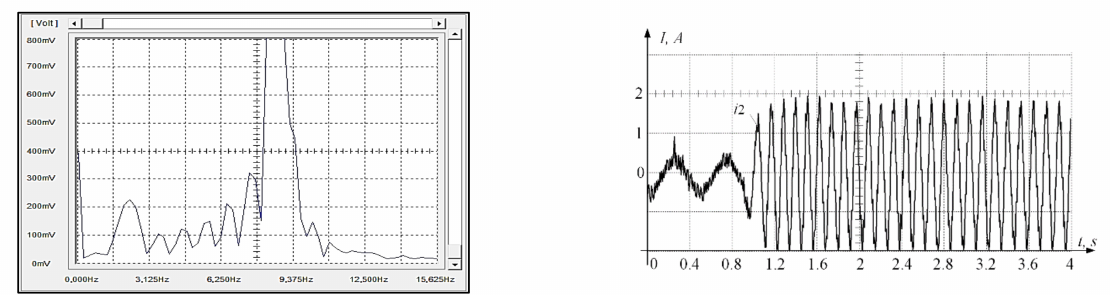
Figure 10. Rotor currents and current spectrum in the drive with vector control and speed